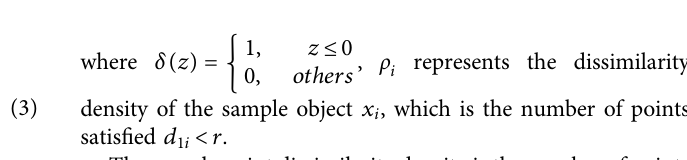
FIGURE 4 | Clustering at a fi xed radius. (A) : The radius is too small; (B) : The radius is too large; (C) : The radius is